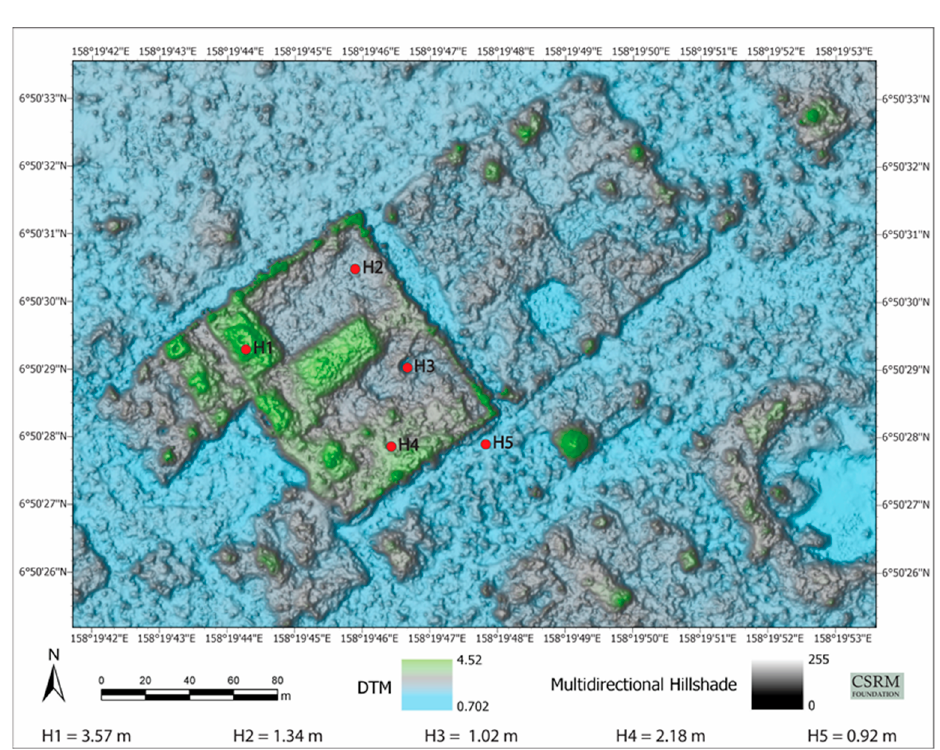
Figure 7. LiDAR-measured elevations on Pan Kediera (H1–H4) and in the main canal running past the islet (H5).